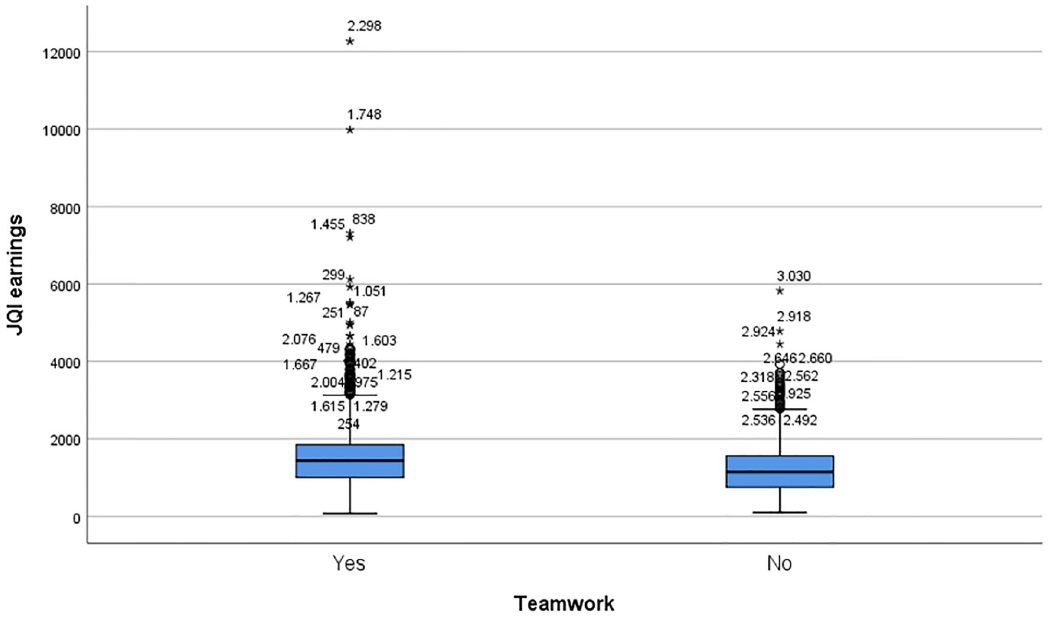
Fig 2. Distribution of JQIEarnings in each class defined by